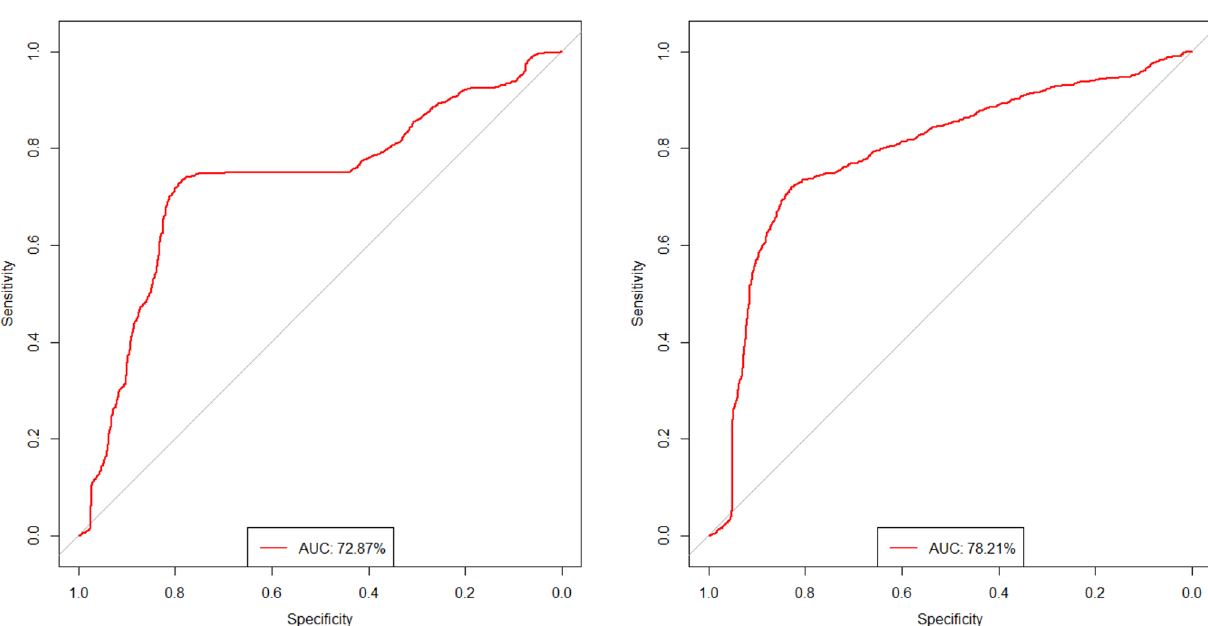
Figure 3. ROC curves of the validation group for GBM model with six features (left) and ten features